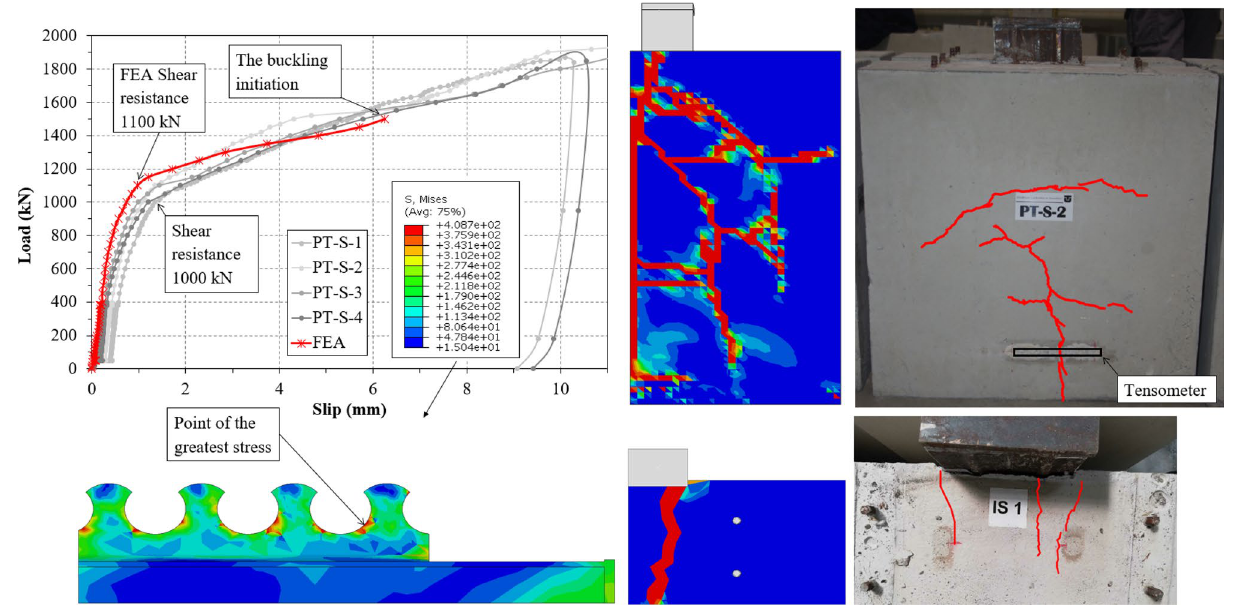
Figure 10. Results of the finite element analysis.